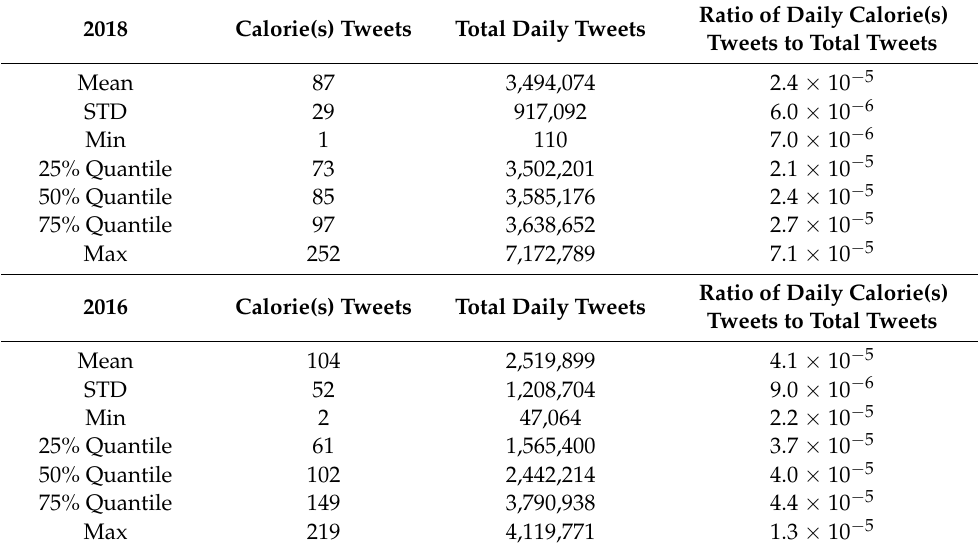
Table 1. Descriptions of tweets about calories in 2018 (implementation of federal calorie labeling law) and 2016 (comparison year).